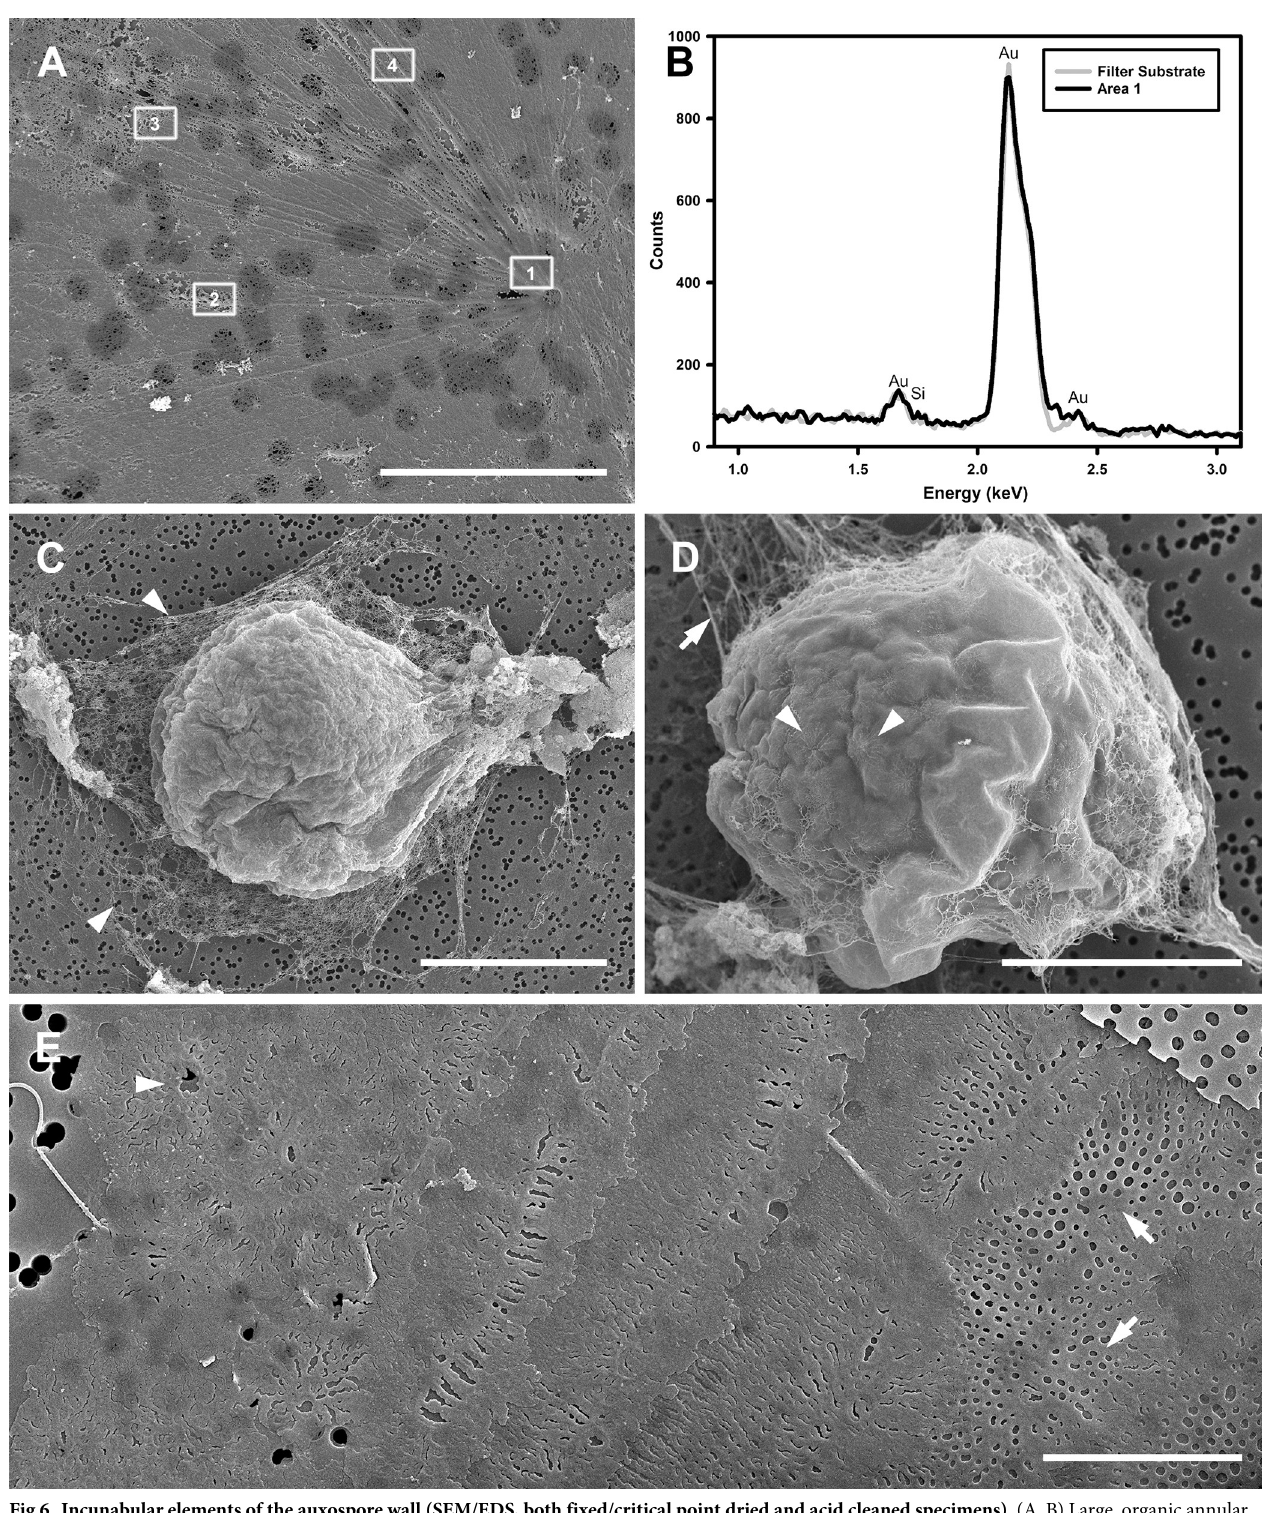
Fig 6. Incunabular elements of the auxospore wall (SEM/EDS, both fixed/critical point dried and acid cleaned specimens). (A, B) Large, organic annular scale, a part of the shroud surrounding auxospores. Framed numbers in (A) indicate where EDS spectra were acquired. (B) Only spectrum from Area 1 is shown compared to spectrum of filter substrate (substrate acquisition area not shown). None of the areas shown here demonstrate the presence of silicon. (C) Egg or zygote swathed in delicate shroud (arrowheads) that was partially damaged and peeled away from cell surface during sample preparation. (D) Spherical